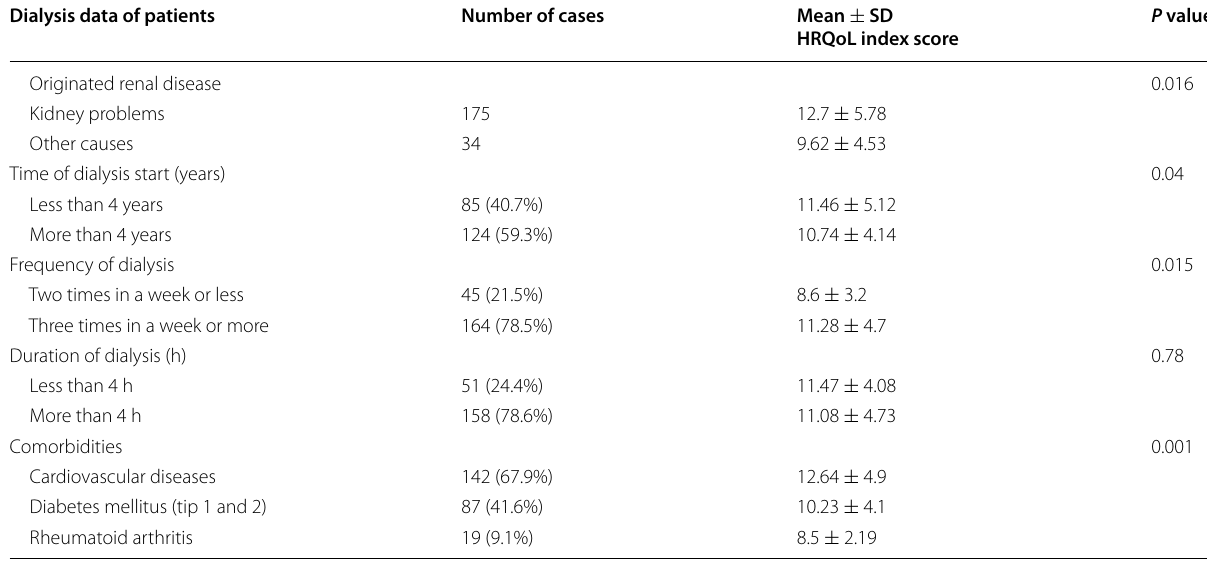
Table 2 The dialysis data and comorbidity of hemodialysis patients Dialysis data of patients